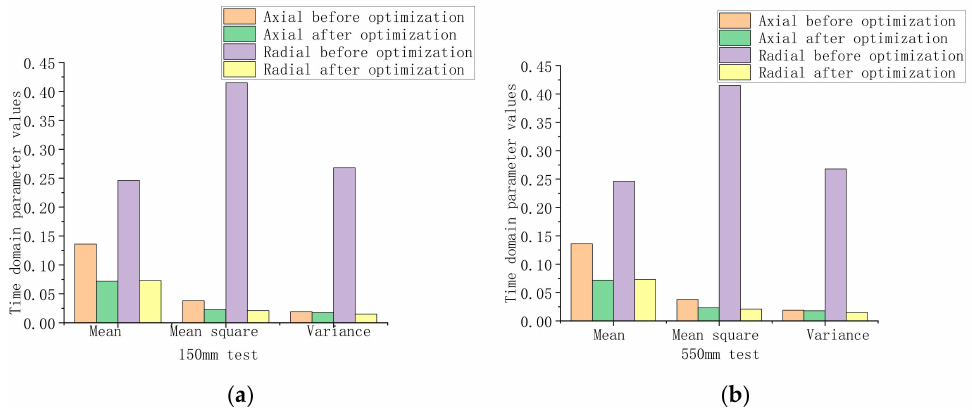
Figure 14. Comparison of shock and vibration test results before and after spindle rotor reduction optimisation: ( a ) 150 mm test; ( b ) 550 mm test.